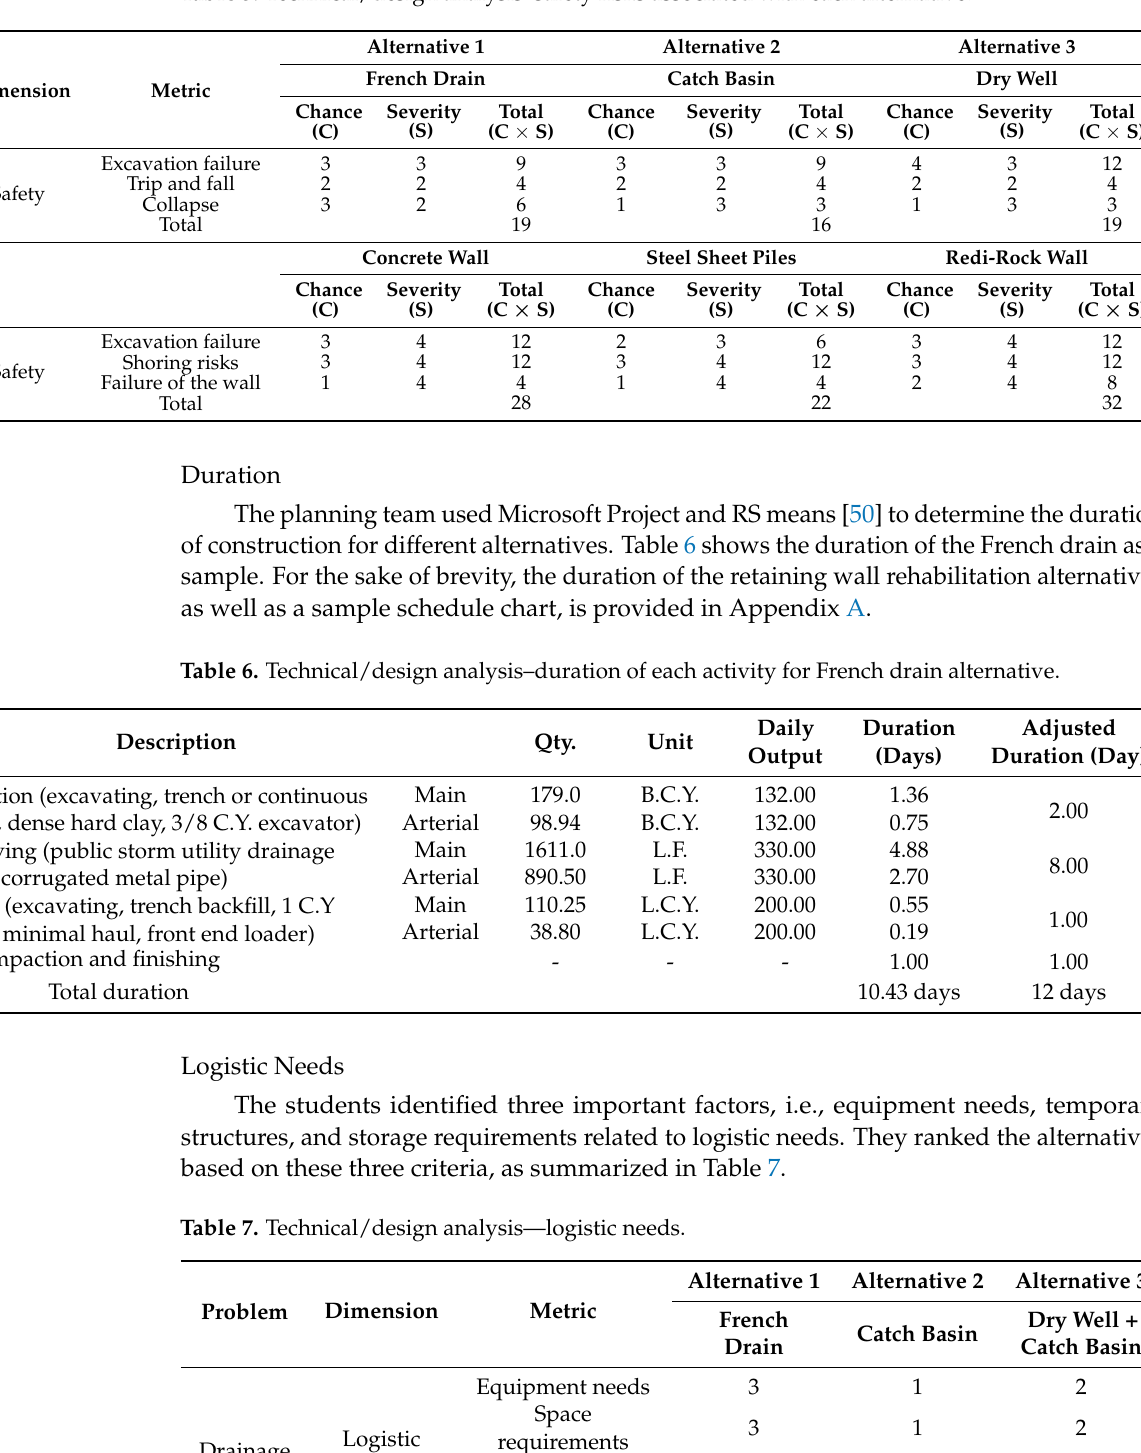
Table 5. Technical/design analysis–safety risks associated with each alternative.